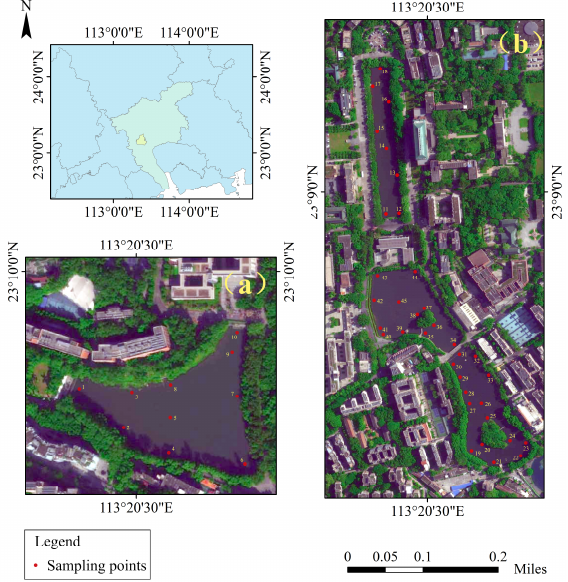
Figure 1. Location of the study area and the distribution of sampling sites. ( a ) North Lake, ( b ) East Lake, Middle Lake and West Lake (from top to bottom).